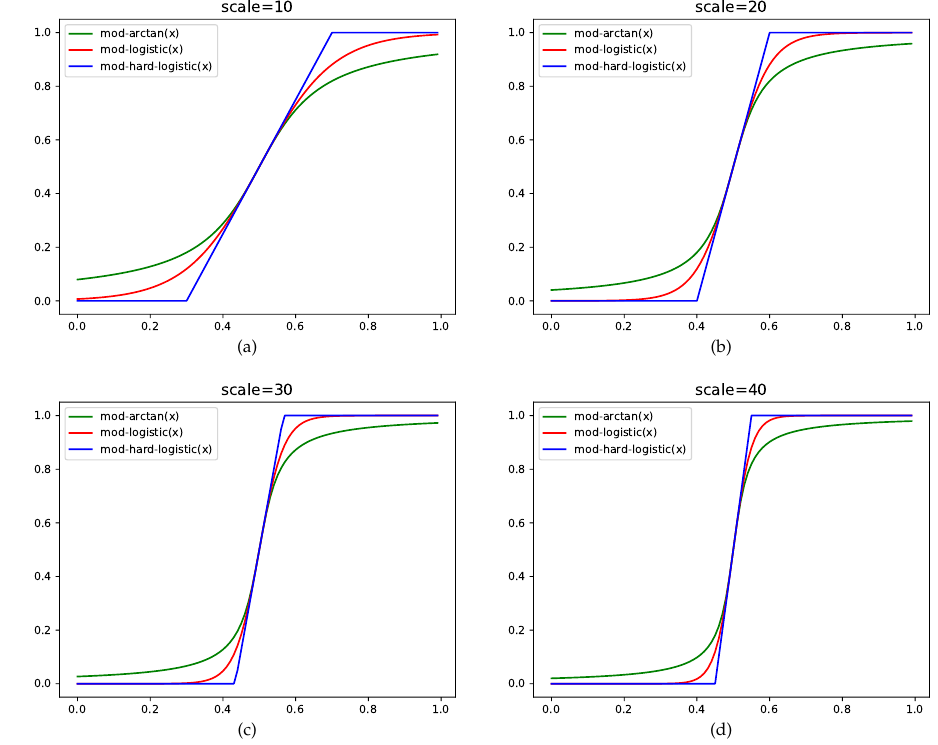
Figure 2. The modified functions with different values of